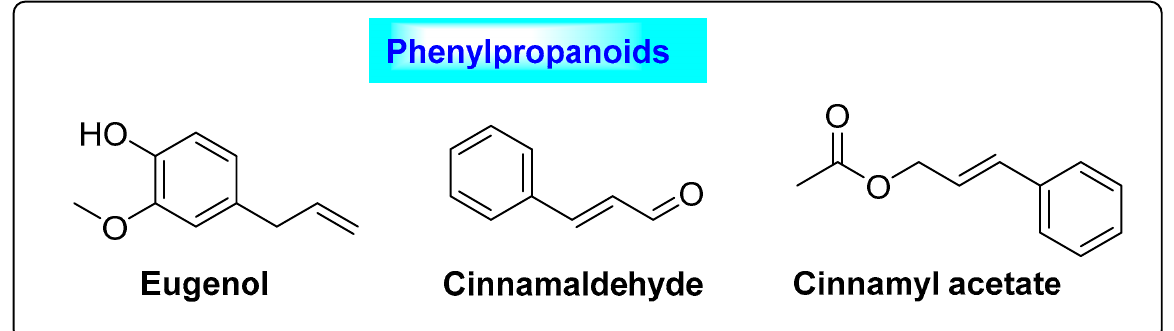
Figure 11. Phenylpropanoids of Cinnamomum cassia that exhibit enzymatic activity.